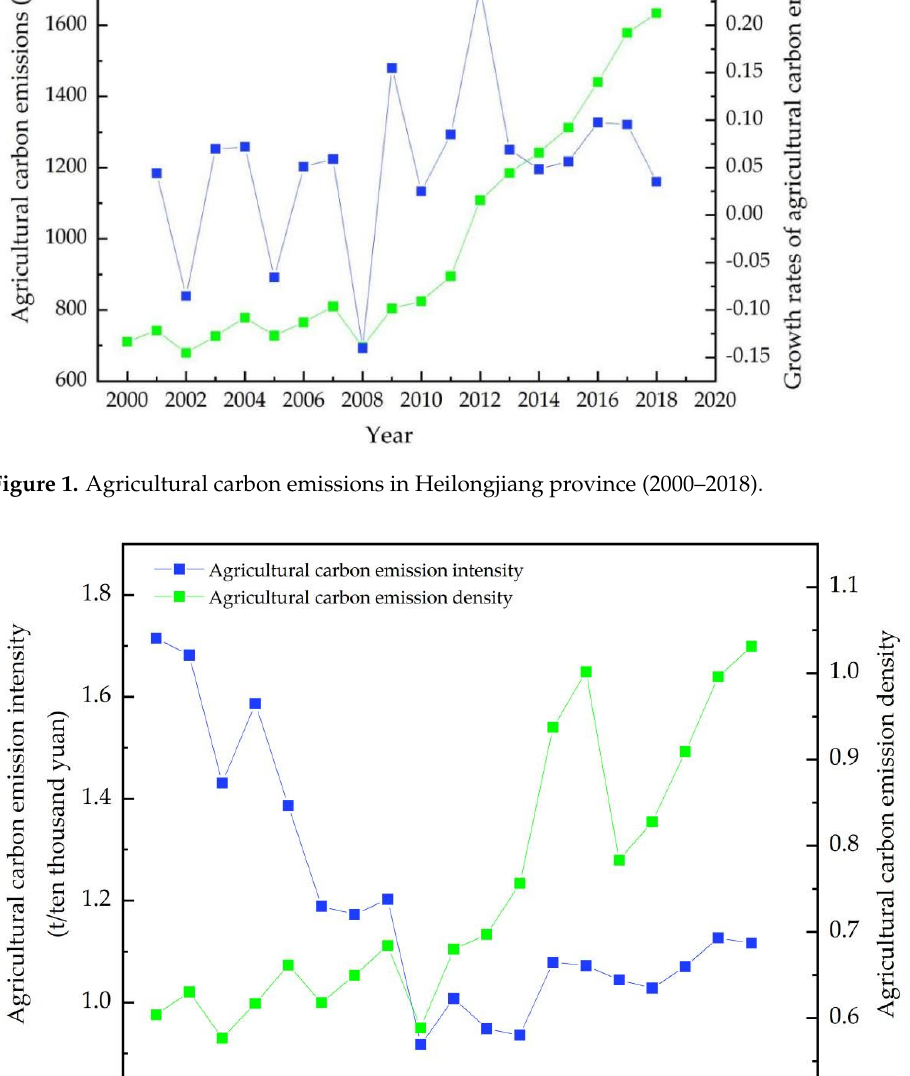
Figure 3. Value added in agriculture and agricultural carbon emissions in Heilongjiang province (2000–2018).